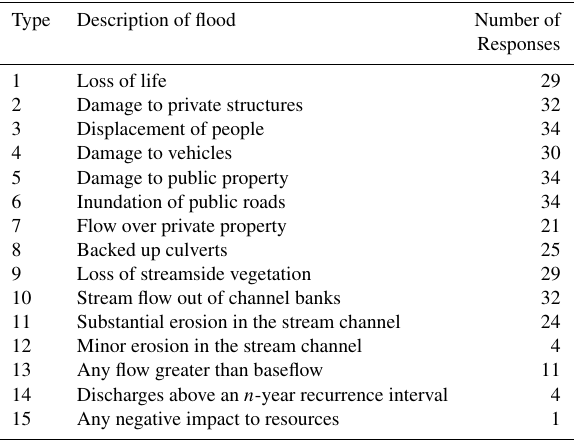
Table 2. Results of which socioeconomic losses were considered a flooding event. Types 14 and 15 are write-in responses.